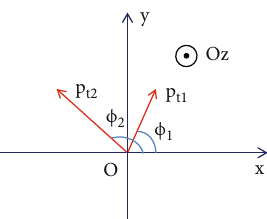
Figure 1: The right-handed Cartesian coordinate system O - xyz . The beam direction which is along the Oz axis points from the inside to the outside. The reaction plane is the plane xOz , and the transverse plane is the plane xOy which is perpendicular to the beam direction. In the fi gure, ϕ 1 ð ϕ 2 Þ is the angle of vector p t 1 ð p t 2 Þ measured with respect to the Ox axis in the plane xOy